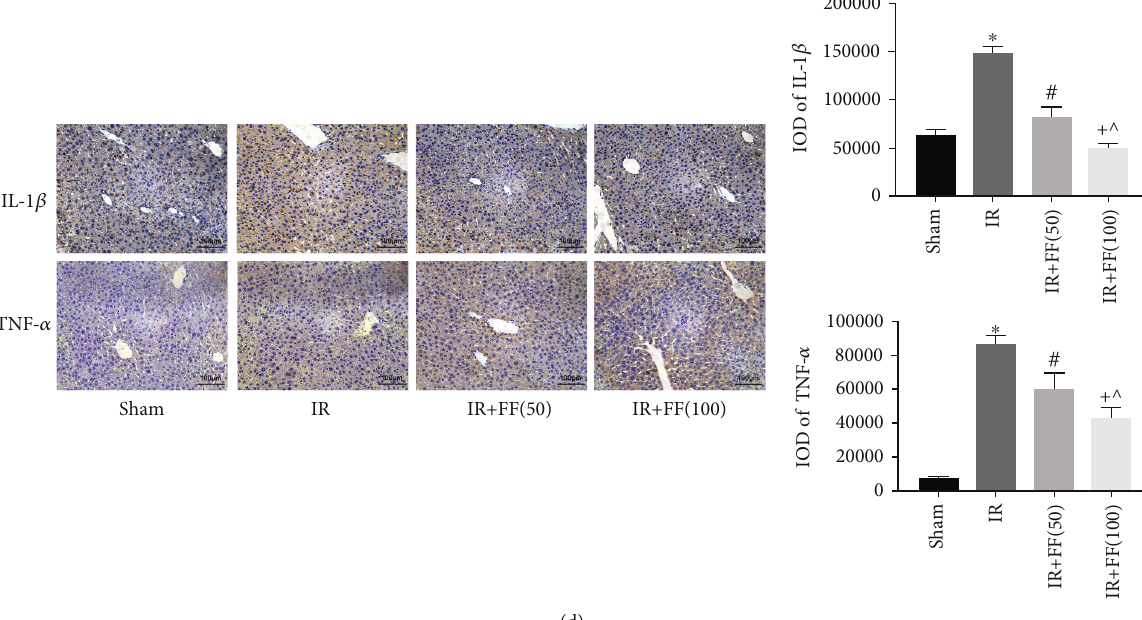
Figure 2: Feno fi brate reduced the expression of in fl ammatory cytokines. (a) Serum IL-1 β and TNF- α were detected by ELISA. (b) Relative IL-1 β and TNF- α mRNA levels were determined by qRT-PCR. (c) Western blot analysis of TNF- α , IL-6, and IL-1 β protein levels. The western blot results were quanti fi ed with ImageJ 8.0 software. (d) Immunohistochemical staining (200x) showed expression of IL-1 β and TNF- α protein in liver tissues at 8 hours after reperfusion. Final evaluations were made using Image-Pro Plus 6.0 software to calculate the IOD of the positive staining area. Data are presented as mean ± SD ( n = 6 ; ∗ P < 0 : 05 for IR vs. sham; # P < 0 : 05 for IR+FF (50) vs. IR; + P < 0 : 05 for IR+FF (100) vs. IR; ^ P < 0 : 05 for IR+FF (50) vs. IR+FF